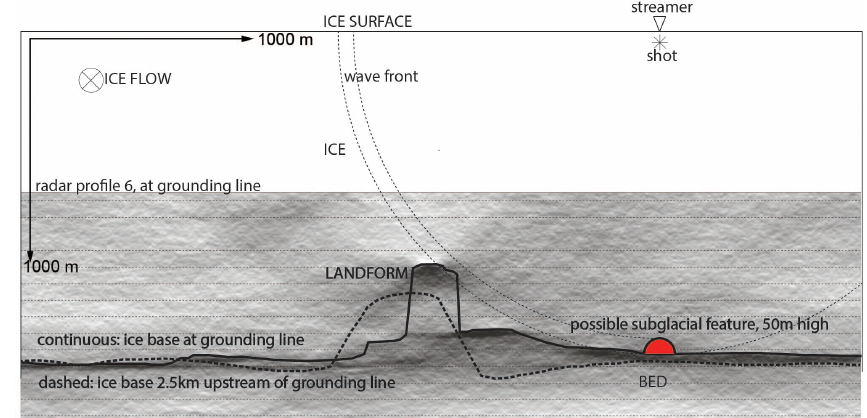
Figure 8. Cross section of the seismic recording geometry of profile I during SP 11 to 17 when the subglacial feature was recorded. The shooting and ice-flow direction are into the page, perpendicular to the cross section. The continuous and dashed black lines represent the ice base at the GL (continuous, profile 6) and 2km upstream (dashed, profile 5) from the GL. The subglacial feature can either be at nadir, in which case its dimensions are represented by the red semi-circle, or the feature can be off-nadir, in which case the feature likely represents the top of the subglacial channel from profile 6. The spherical wave front (dashed quarter circle) shows the off-nadir reflections from the top the basal channel (profile 6) arrive just before the nadir flat bed reflections (so when no semi-circle would be